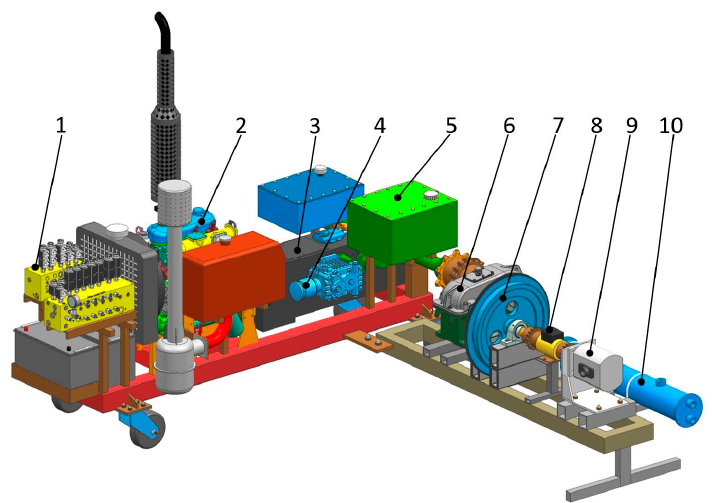
Figure 4. Test bench assembly drawing. 1. Hydraulic control system; 2. Engine; 3. Drive rear axle; 4. HST; 5. Fuel tank; 6. Gear Increaser; 7. Flywheel; 8. Speed & torque sensor; 9. Hydraulic pump; and 10. Cooler.